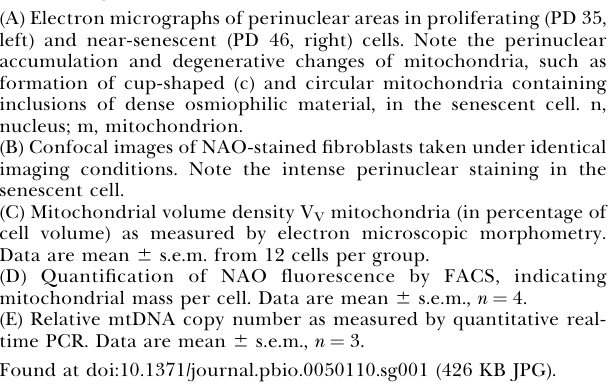
Figure S1. Senescent MRC5 Fibroblasts Contain More Mitochondria Than Young Ones (A) Electron micrographs of perinuclear areas in proliferating (PD 35, left) and near-senescent (PD 46, right) cells. Note the perinuclear accumulation and degenerative changes of mitochondria, such as formation of cup-shaped (c) and circular mitochondria containing inclusions of dense osmiophilic material, in the senescent cell. n, nucleus; m, mitochondrion. (B) Confocal images of NAO-stained fibroblasts taken under identical imaging conditions. Note the intense perinuclear staining in the senescent cell. (C) Mitochondrial volume density V V mitochondria (in percentage of cell volume) as measured by electron microscopic morphometry. Data are mean 6 s.e.m. from 12 cells per group. (D) Quantification of NAO fluorescence by FACS, indicating mitochondrial mass per cell. Data are mean 6 s.e.m., n ¼ 4. (E) Relative mtDNA copy number as measured by quantitative real- time PCR. Data are mean 6 s.e.m., n ¼ 3. Found at doi:10.1371/journal.pbio.0050110.sg001 (426 KB JPG). Figure S2. Hierarchic Cluster Analysis of Gene Expression in Senescent MRC5 Cells Young fibroblasts arrested by confluency in G0/G1 (four independent experiments, YOUNG) were compared to fibroblasts grown to senescence under normoxia (three experiments, SEN). A total of 2,610 probe sets (accession numbers) were changed at least 2-fold between YOUNG and SEN, with the majority (1,552) of these being down-regulated in senescent cells. Only a limited number of these changes were confirmed in fibroblasts grown to senescence under hyperoxia (two experiments, HYPER). Expression levels are colour- coded as shown on the right. Found at doi:10.1371/journal.pbio.0050110.sg002 (673 KB JPG). Figure S3. Up-Regulation of Signalling and Metabolic Enzymes in Senescence and under Hyperoxia RT-PCR was performed for the genes indicated on the right using conditions indicated in Table S1. GAPDH was measured as loading control. H, cells kept under hyperoxia for 47 d; S, senescent cells (PD 48); Y, young cells (PD 25). Found at doi:10.1371/journal.pbio.0050110.sg003 (139 KB JPG). Figure S4. Effect of Long-Term DNP Treatment on MMP and Mitochondrial Mass (A) DNP treatment decreases MMP in pre-senescent, but not in senescent cells. MMP was measured as FL3/FL1 ratio of JC-1–stained cells treated with 250 l M DNP for the indicated times. Data are mean 6 s.e.m., n ¼ 3. Stars denote significant differences to controls with p ¼ 0.05 (Paired t -test, two-tailed). (B) Long-term DNP treatment partially compensates for the increase in mitochondrial mass during senescence. Mitochondrial mass measured as FL1 fluorescence of NAO-stained cells. Data are mean 6 s.e.m., n ¼ 3. Star denotes significant differences to controls with p ¼ 0.003 (Paired t -test, two-tailed). Found at doi:10.1371/journal.pbio.0050110.sg004 (147 KB JPG). Figure S5. DNP Slows Down the Accumulation of Sen- b -Gal–Positive Cells Control cells at PD 46 (A) and DNP-treated cells at PD 50 (B) were both stained for Sen- b -Gal at day 56 of the experiment. Found at doi:10.1371/journal.pbio.0050110.sg005 (237 KB